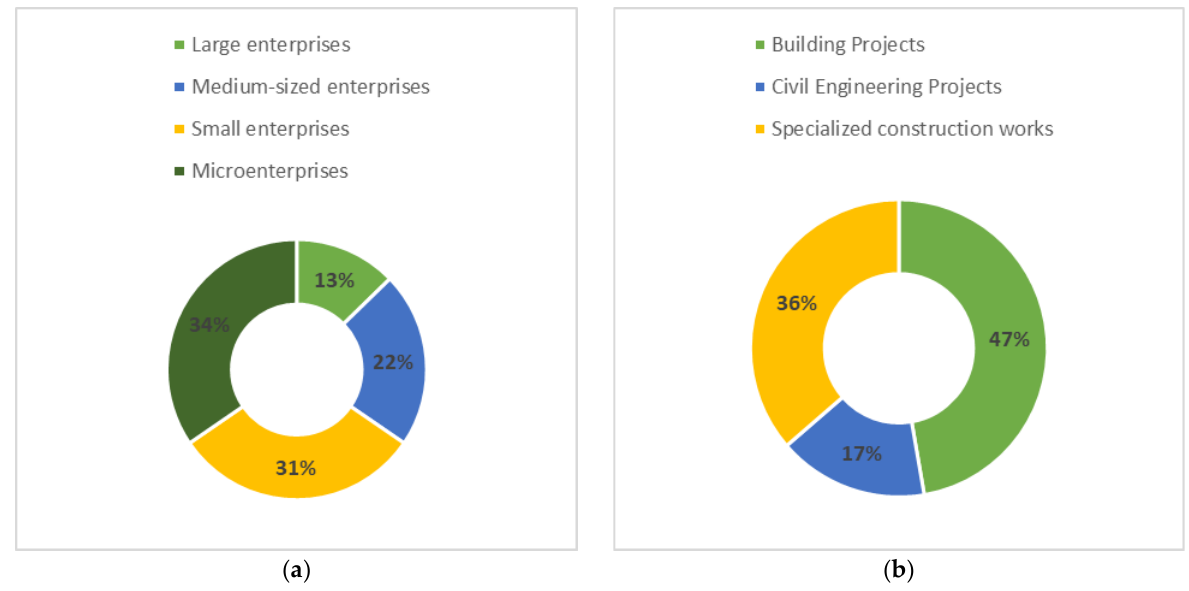
Figure 1. Research sample by ( a ) enterprise size and ( b ) NACE classification.